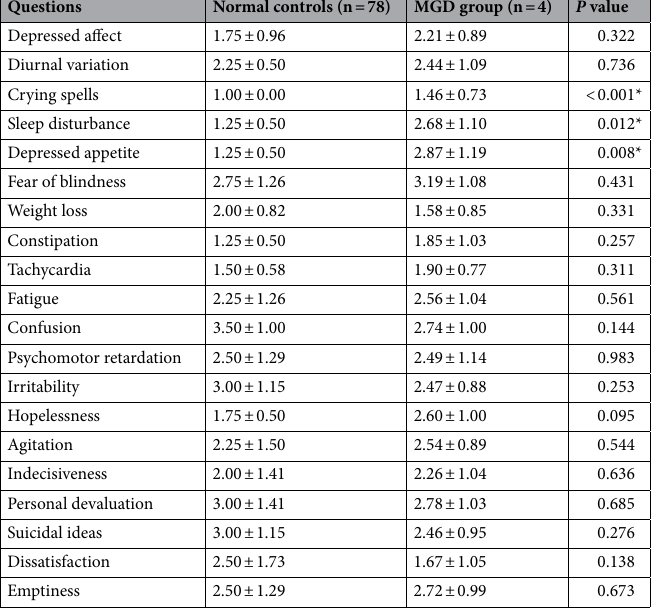
Table 5. Analysis of M-SDS questionnaire survey among depression cases. *P < 0.05 was considered statistically